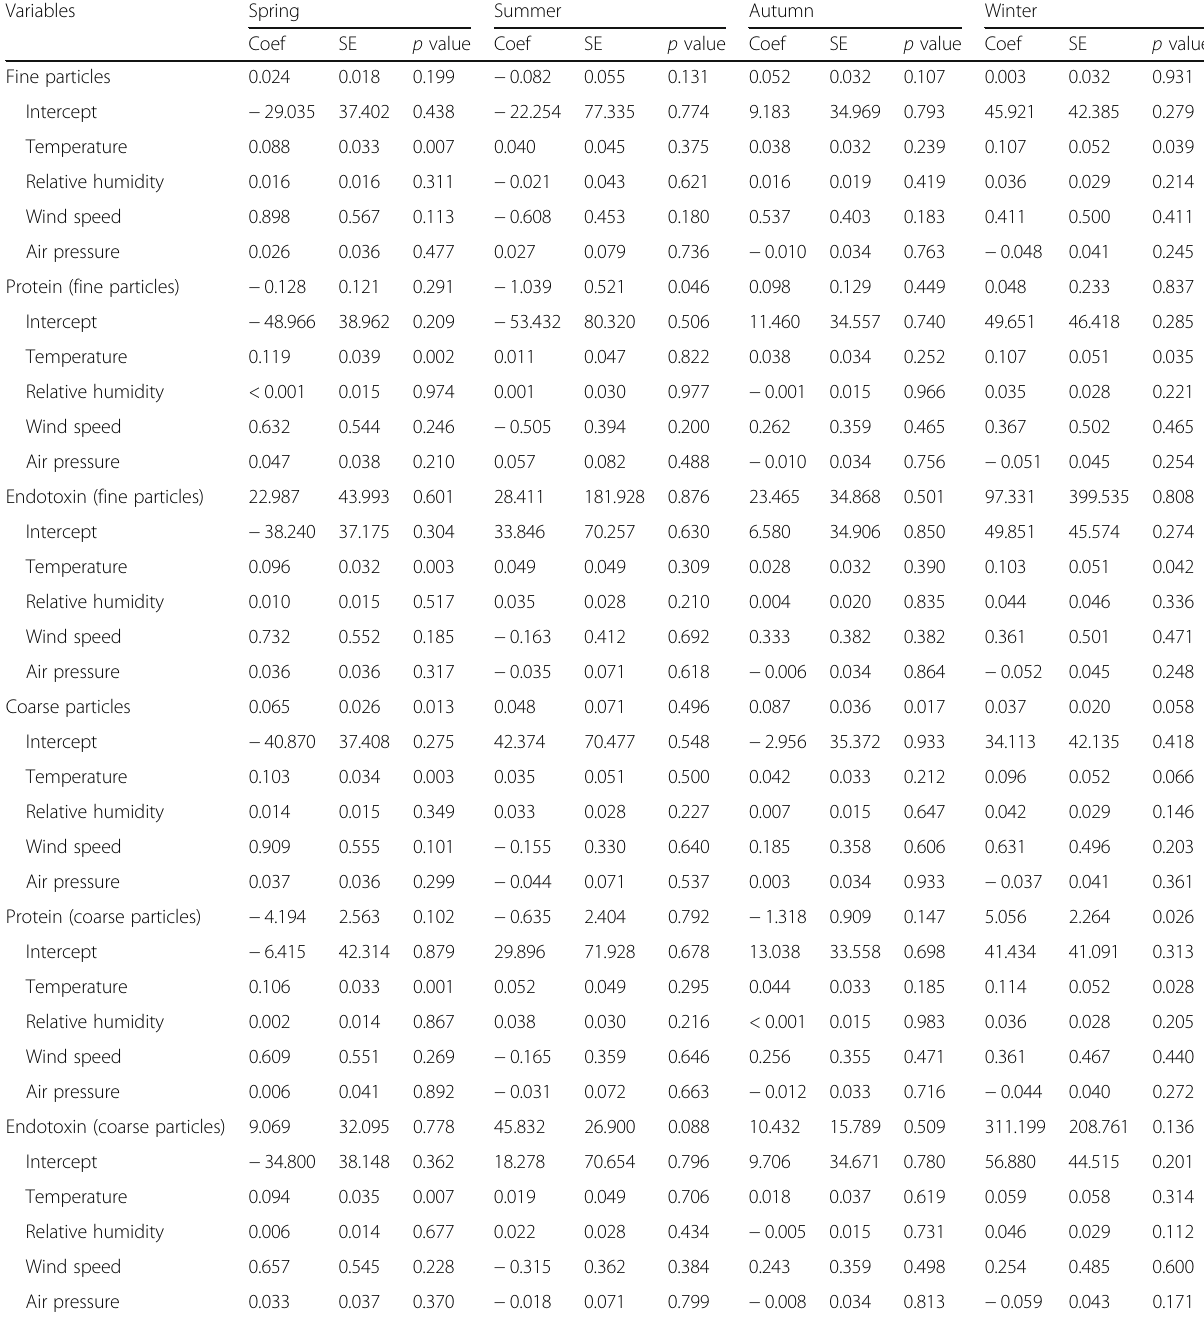
Table 5 Results of seasonal Poisson regressions of air pollutants and meteorological factors on emergency department visits